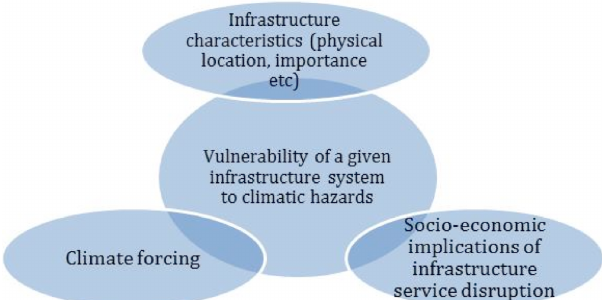
Table 3. Scales used for V3 for all infrastructure systems.